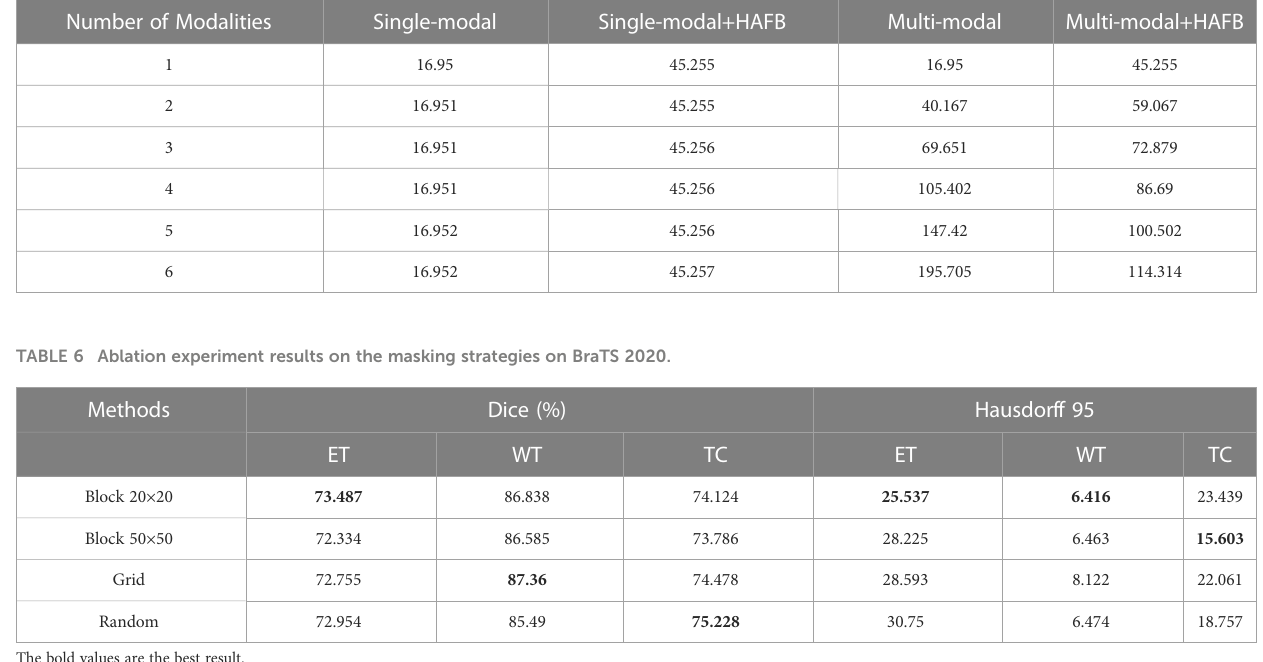
TABLE 5 Comparison of the number of model parameters (M).